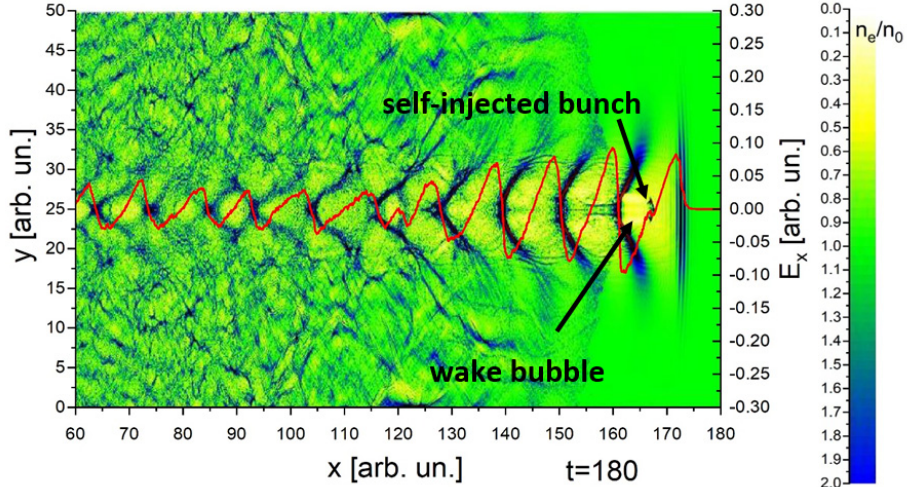
Figure 2. Excitation of a wakefield by a laser pulse in homogeneous plasma t = 180 T 0 . The self-injected bunch is close to the middle of the bubble. Separate areas in which the ratio of electron densities reaches a value of 9 are highlighted in red. Plasma electron density and longitudinal accelerating field distributions. x, y are normalized to λ , E x is normalized to E 0 = m e c ω ℓ /2 π e .